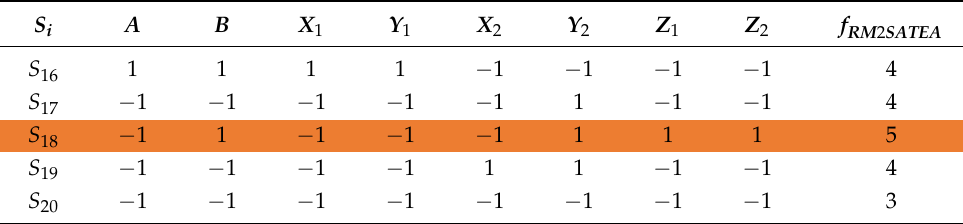
Table A4. S 18 selected as candidate in Party 4.